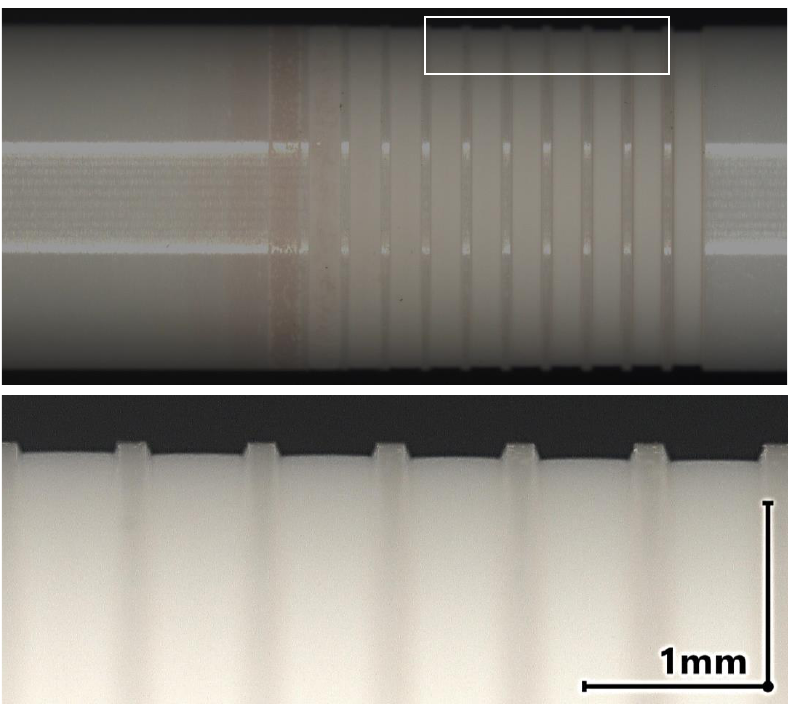
Figure 4. Top : Cylindrical ATZ sample HTZ 500 LC with a blank diameter of D = 6 mm after the laser ablation experiment at an angle of irradiation θ = 45°. The pulse energy is increased from E p = 3 µ J (left) to E p = 21 µ J (right). Bottom : Detailed view of the grove profiles machined with a pulse energy from E p = 15 µ J to E p = 20 µ